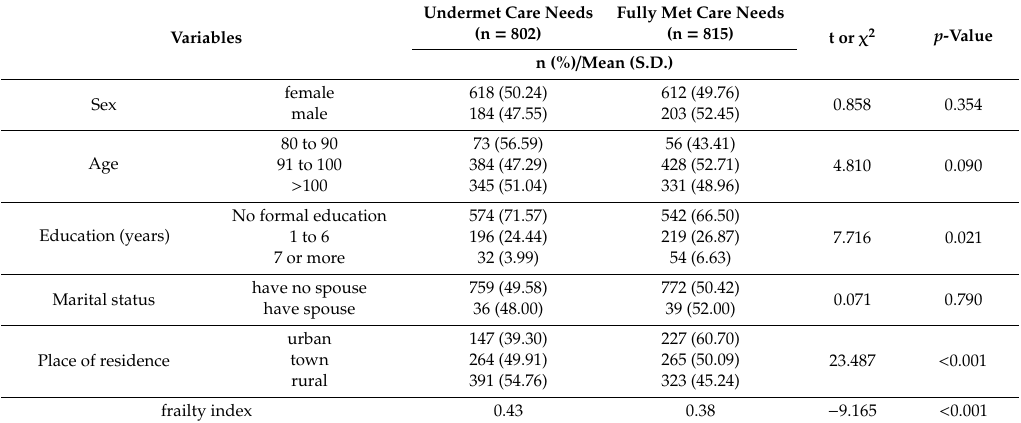
Table 2. Sociodemographic characteristics according to undermet care needs.